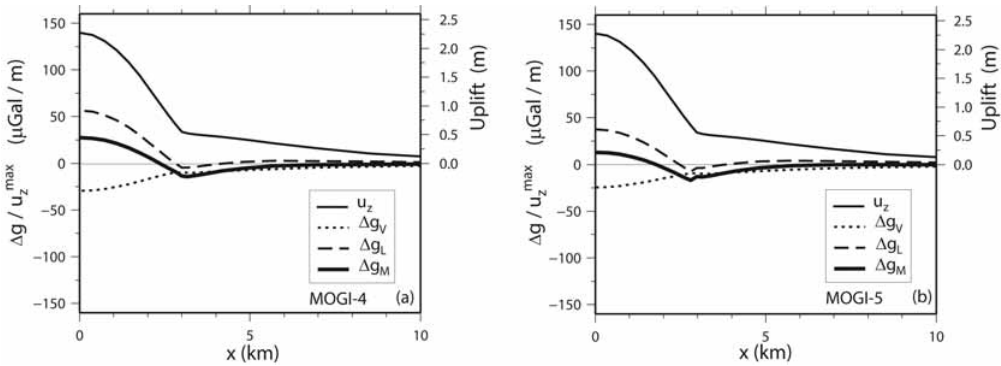
Fig. 9a,b. Gravity terms normalized to the maximum uplift u z max , and vertical displacement due to an inflating spherical pressure source in a medium characterized by: a) heterogeneous caldera µ 1 / µ 0 = 0.1; b) caldera with heterogeneous rigidity µ 1 and density ρ 1